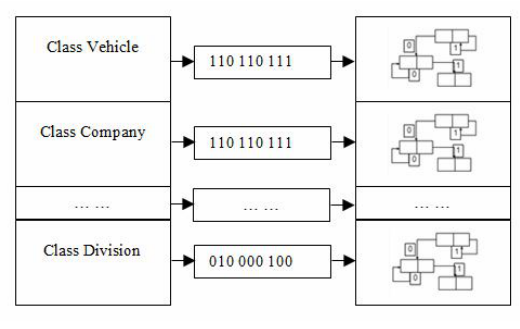
Figure 7. Construction signature graph